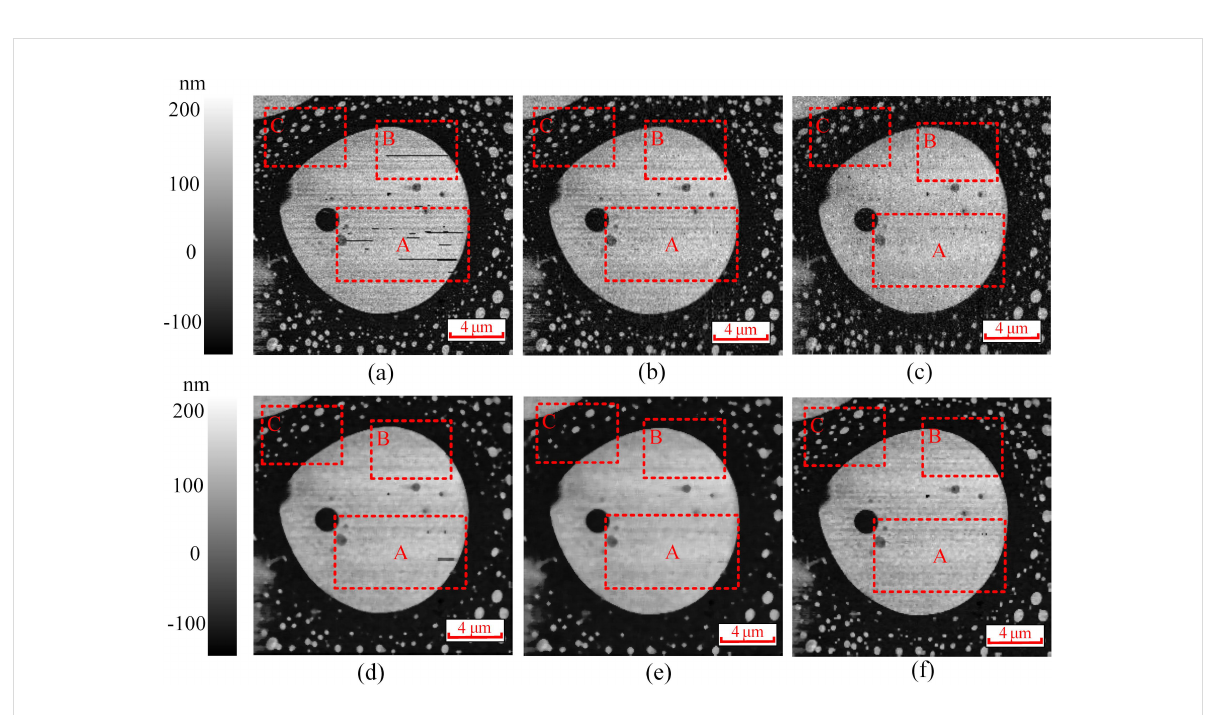
Figure 8: (a) AFM image with added noise. (b) Denoised image obtained by the interval-BCS denoising. (c) Denoised image obtained by the self- comparison-BCS denoising. (d) Denoised image obtained by the median filter with a filter window of 4 × 4 pixels. (e) Denoised image obtained by the median filter with a filter window of 5 × 5 pixels. (f) Denoised image obtained by the adaptive median filter with a maximum window size of 7 × 7 pixels and a minimum window size of 3 × 3